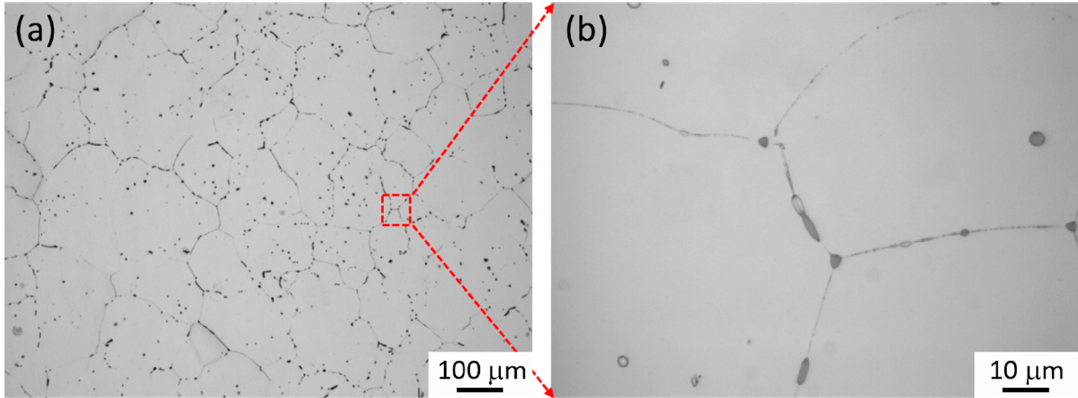
Figure 2. Optical micrographs of as-homogenized ZX10 alloy: ( a ) Low magnification, ( b ) High magnification.